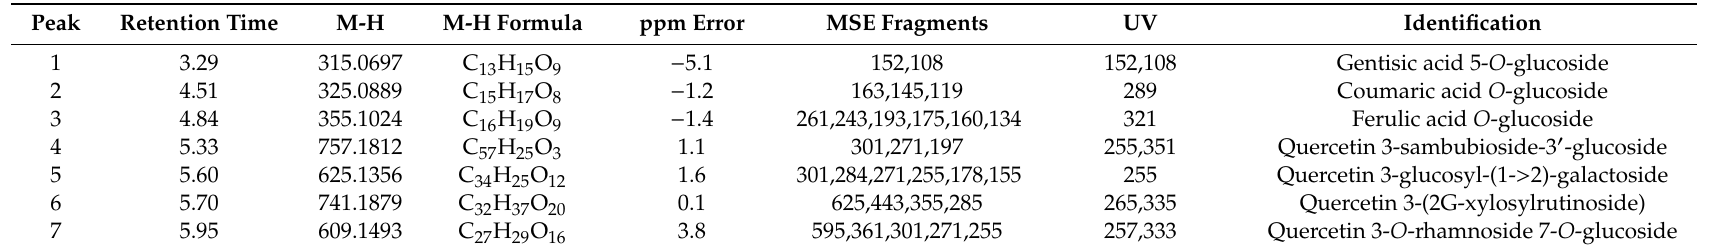
Table 1. Identification of phenolic compounds in di ff erent cowpea cultivars by a UPLC–QTOF / MS